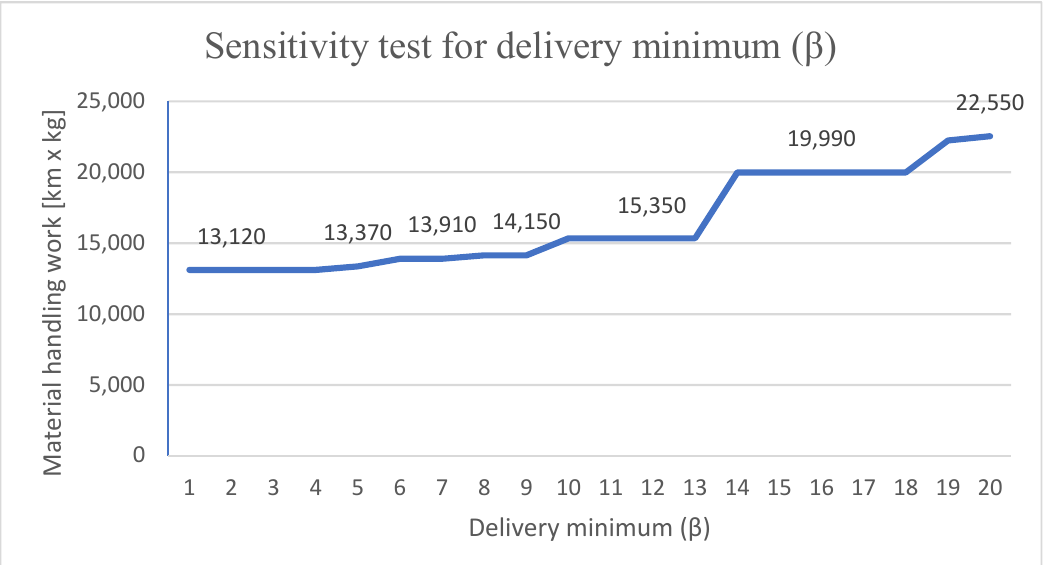
Figure 9. Delivery minimum sensitivity test.